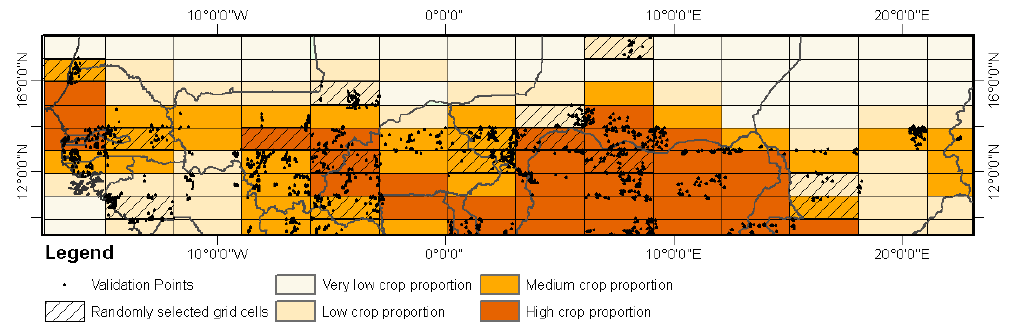
Figure 8. Crop proportion of each grid cell and randomly-sampled grid cells for SVM classification with the best selected features. A higher crop proportion is observed in lower